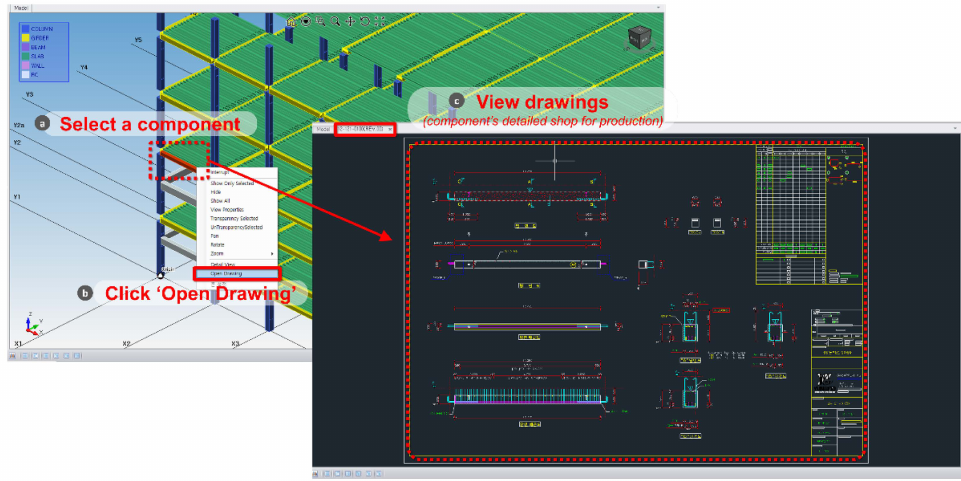
Figure 5. Three-dimensional model view–2D shop drawing